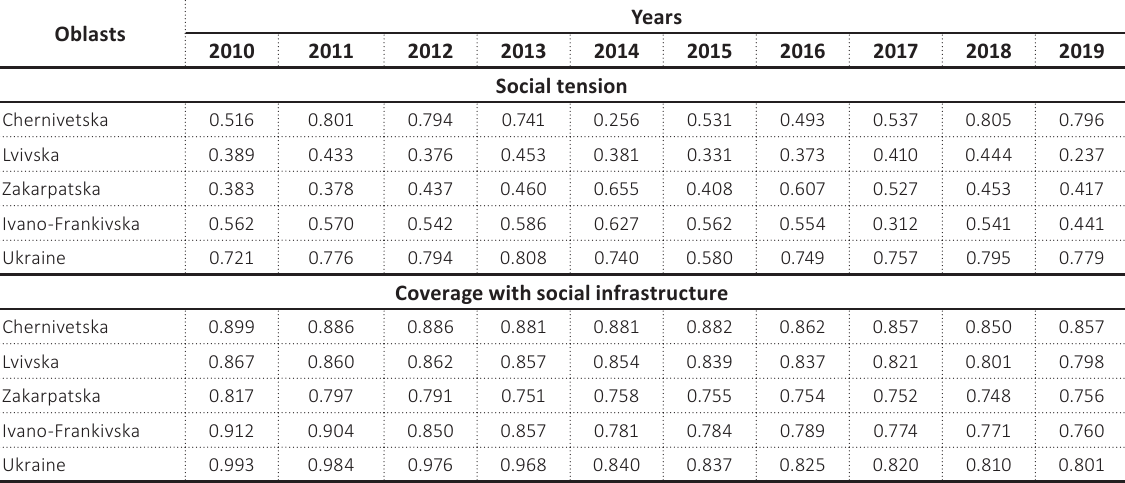
Source: Developed based on the authors’